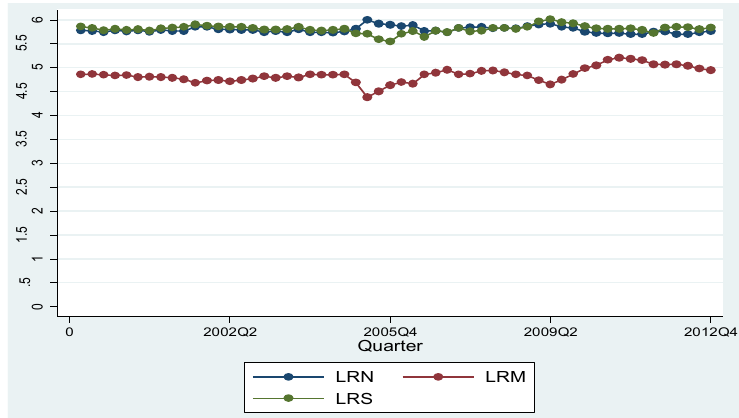
Figure 1. Prices of Spruce and Pine Sawlogs Trends. LPN , LPM , and LPS denote the natural logarithm of the real delivery prices of spruce and pine timber (in Swedish Krona, SEK) in the Northern, central, and Southern region, respectively.